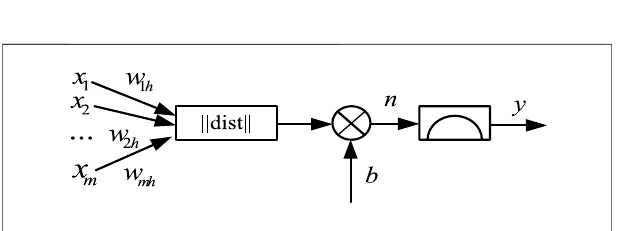
FIGURE 8 | RBF neural model. RBFNN structure as shown in Figure 9 .